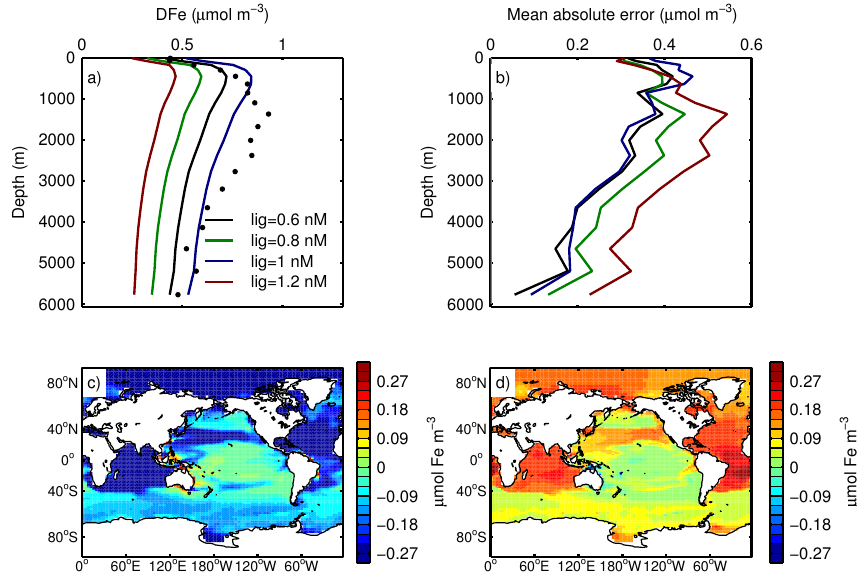
Figure 17. Impact of varying the globally constant ligand concentration on the globally averaged vertical profiles of dissolved iron (a) , vertical profiles of the horizontally averaged absolute differences between model and the observations (b) , difference between annual mean surface dissolved iron concentrations when ligands are set at constant values of lig = 0.6nM and lig = 1.0nM (c) , difference between annual mean surface dissolved iron concentrations when ligands are set at constant values of lig = 1.2nM and lig = 1.0nM (d) .